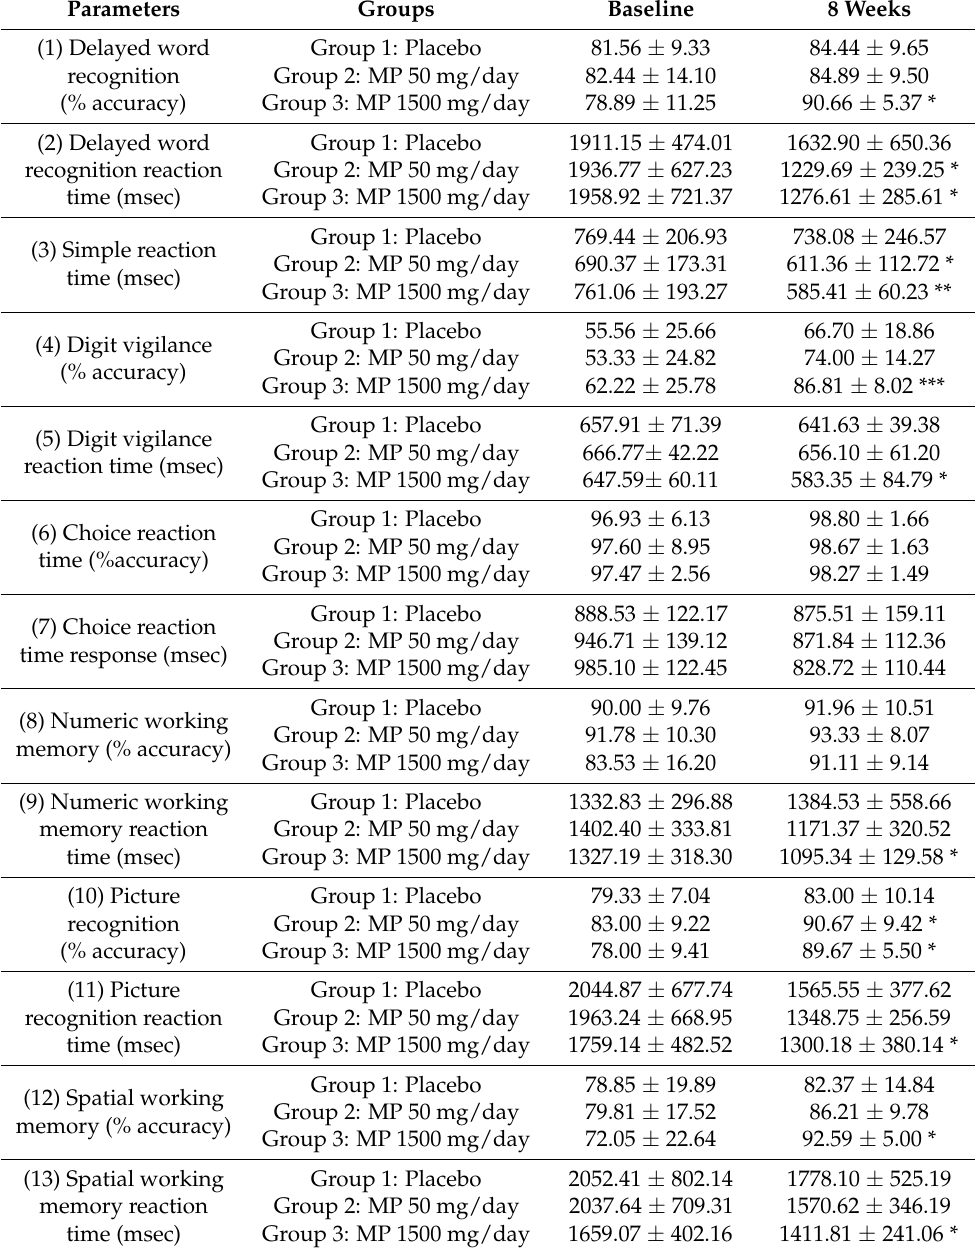
Table 3. The effect of various doses of the developed supplement containing the combined extract of Polygonum odoratum and Morus alba leaves on working memory assessed using computerized battery